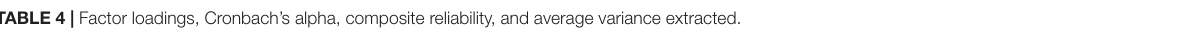
TABLE 4 | Factor loadings, Cronbach’s alpha, composite reliability, and average variance extracted.